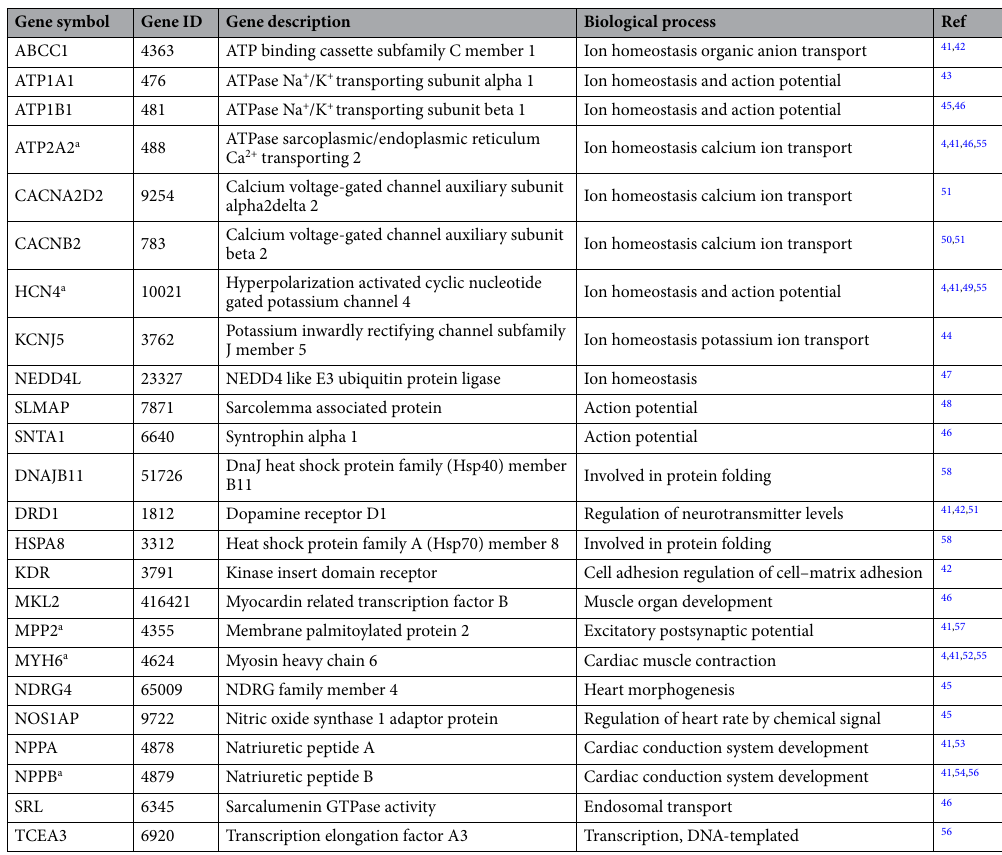
Table 1. T3-induced DEGs associated with QT-interval regulation. List of known QT interval-related DEGs identified with RNAseq analysis. Gene nomenclature details were obtained from Entrez Gene database. a Known T3-reponsive